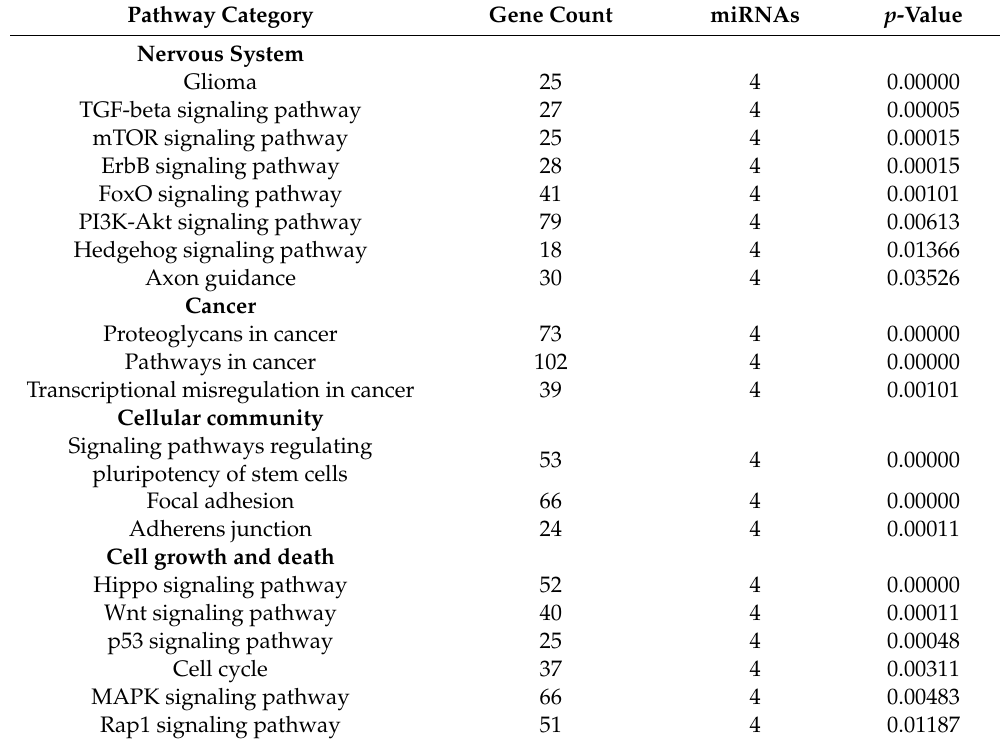
Table 4. Kyoto Encyclopedia of Genes and Genomes (KEGG) pathway analysis and pathway category of four target microRNAs in serum exosomes from patients with focal cortical